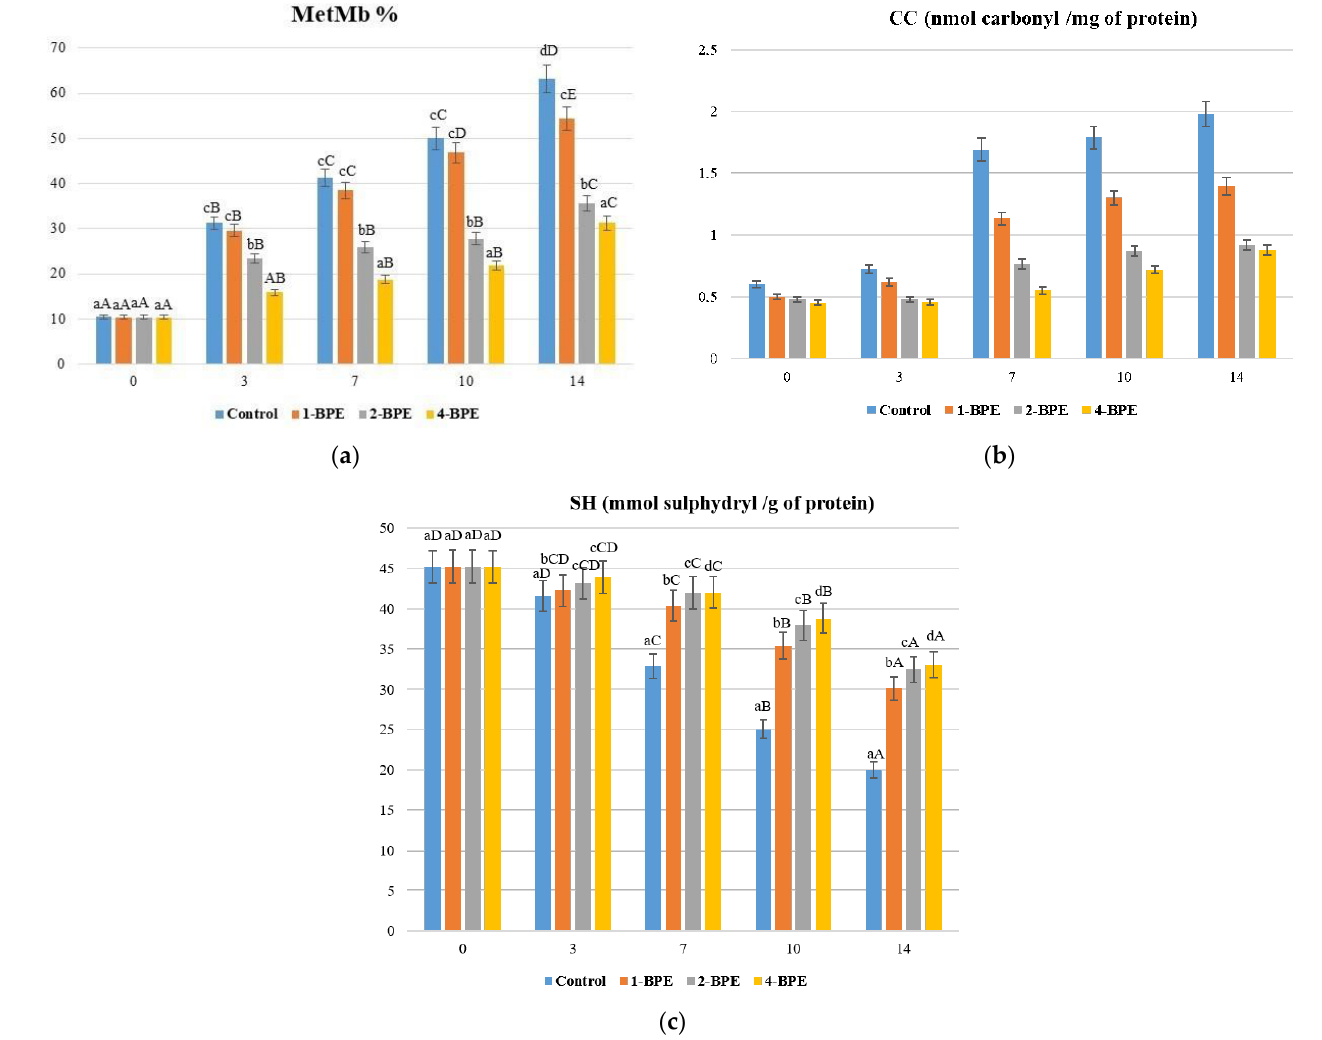
Figure 3. Effect of the films (control (0%), 1-BPE (0.25%), 2-BPE (0.5%), and 4-BPE (1%)) on ( a ) MetMb (%), ( b ) CC (nmol carbonyl/mg of protein), and ( c ) SH (mmol sulphydryl/g of protein) of raw minced meat beef stored at 4 °C for 14 days; ±: standard deviation (SD) of three replicates; a – d: mean values within all the samples not followed by a similar letter in the same column varied significantly ( p < 0.05); A – E: mean values during storage not followed by a similar letter in the same line varied significantly ( p < 0.05).